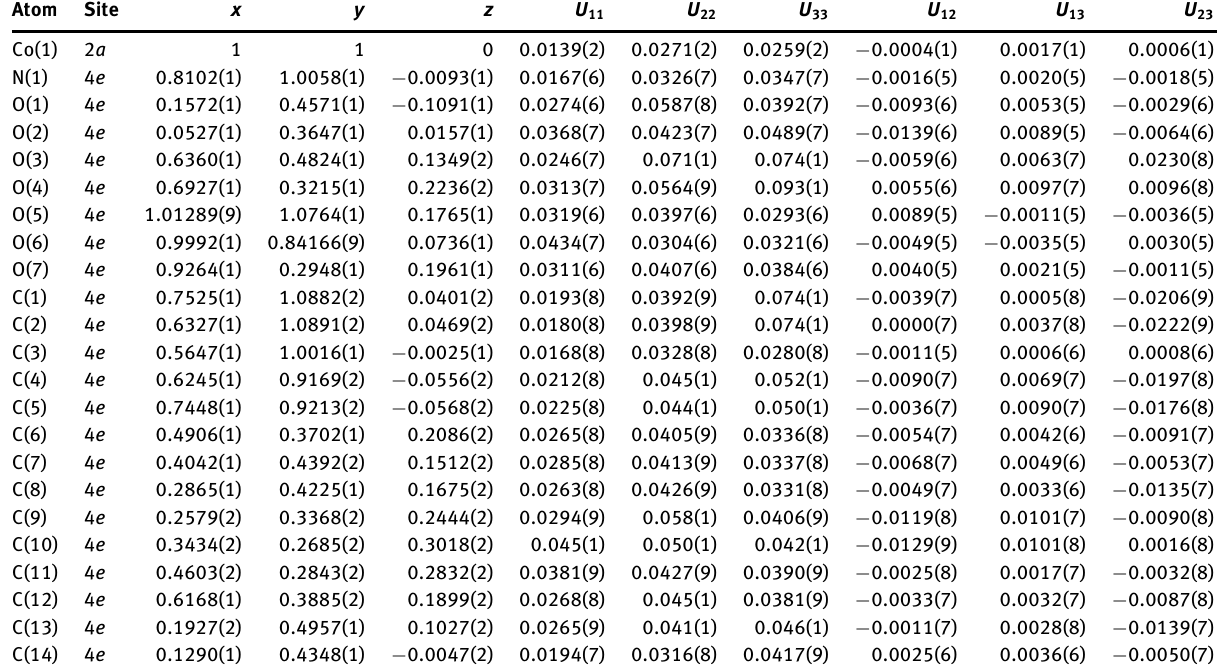
Table 3: Atomic coordinates and displacement parameters (in Å 2